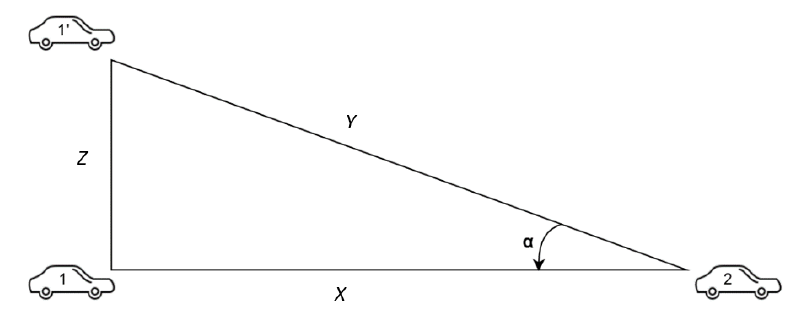
Figure 4. Example of cars going the same way but having different